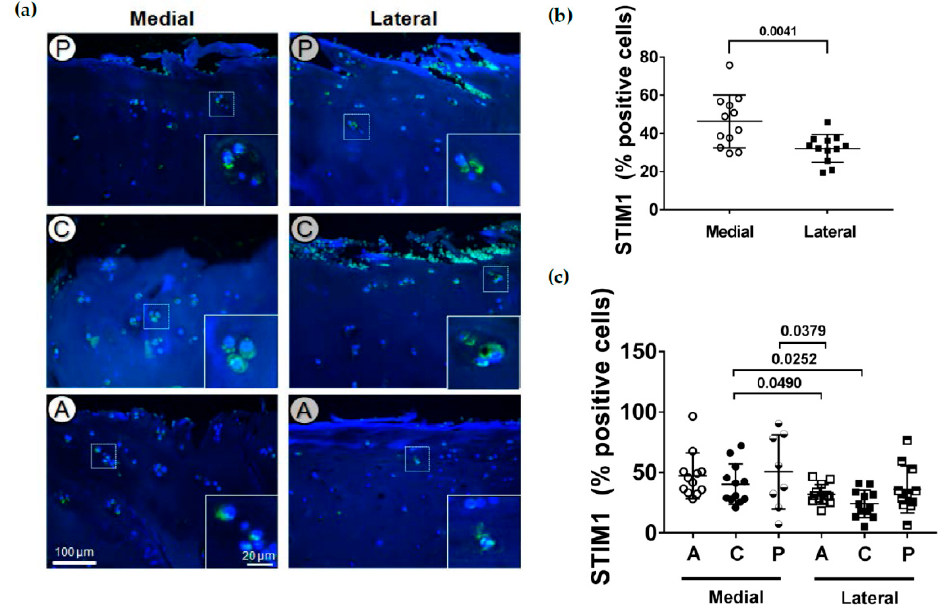
Figure 5. Immunofluorescence staining of STIM1 in chondrocytes. ( a ) STIM1-stained chondrocytes of the upper cartilage zone from the different cartilage subregions (A: anterior, C: central, P: posterior) of the medial and lateral tibial compartments. Magnifications in white boxes show STIM1 localization in individual chondrocytes. Representative STIM1-stained sections of the different subregions. ( b ) Quantitative evaluation of STIM1-positive stained cells in relation to the total number of cells. The total medial compartment had a significantly higher number of STIM1-positive chondrocytes compared to the lateral compartment ( n = 12). ( c ) Percentage of STIM1-positive stained cells for the different subregions (A: anterior, C: central, P: posterior) at the medial and lateral tibial compartments ( n = 8–12 per subregion). Values are represented as scatter plots with indicated mean. Significance between medial and lateral tibial compartments was evaluated using the paired t-test and between subregions using the ANOVA with repeated measurements and Duncan’s multiple range test for post-hoc analysis.